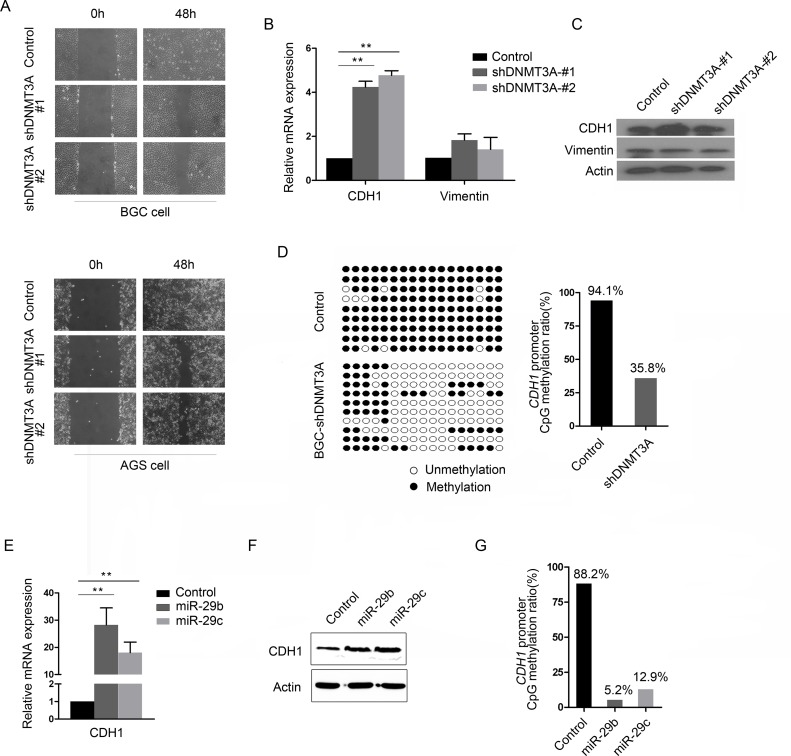
Both of DNMT3A and miR-29b/c are involved in GC migration.(A) Cell migratioin rates of DNTM3A knockdown BGC or AGS cells were compared with control via wound healing assays. Microscopic observation was recorded at 0 and 48 hours after scratching the surface of a confluent layer of cells. (B and C) qRT-PCR (B) and western blot (C) analysis of CDH1 or Vimentin expression in DNMT3A-knockdown BGC-823 cells. β-actin was used as a loading control. (D) Mapping of the methylation status of individual CpG sites in the CDH1 promoter by BGS assay (Left) and bar graphs depicting the CDH1 promoter methylation rates in BGC-control and BGC-shDNTM3A cells (right). The regions spanning the CpG island with 17 CpG sites were analyzed. Black circles represent the methylated CpG sites; white circles represent the unmethylated CpG sites. Each row represents bisulfite sequencing of CDH1 promoter for a single analyzed random clone. (E and F) qRT-PCR (E) and western blot (F) analysis of CDH1 or Vimentin expresion in BGC-823 cells after miR-29b/c mimics or negative control mimics 48-hour transfection(**P<0.01). β-actin was used as a loading control. (G) Bar graphs depicting the CDH1 promoter methylation rates in BGC-823 cells after miR-29b/c mimics or negative control mimics 48-hour transfection. The regions spanning the CpG island with 17 CpG sites were analyzed.